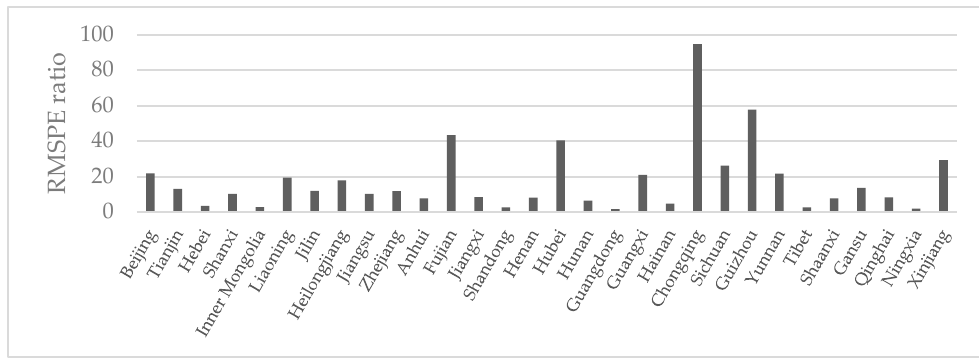
Figure 8. RMSPE ratio of the LQT program.